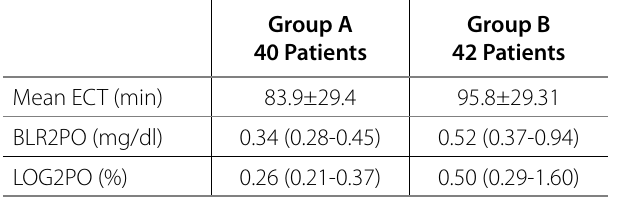
Table 3. Values of variables in Group A and B.